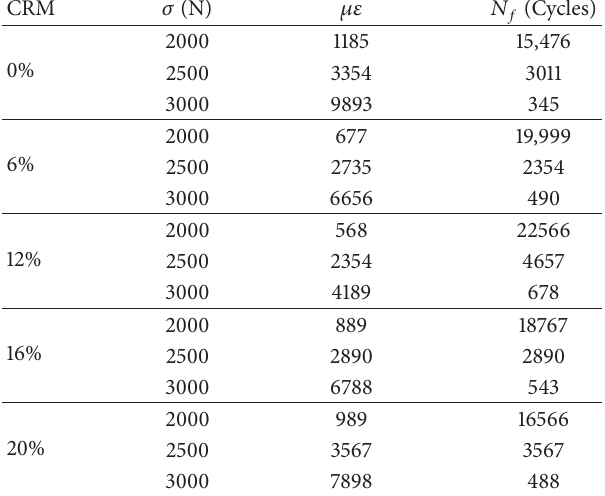
Table 4: Fatigue test